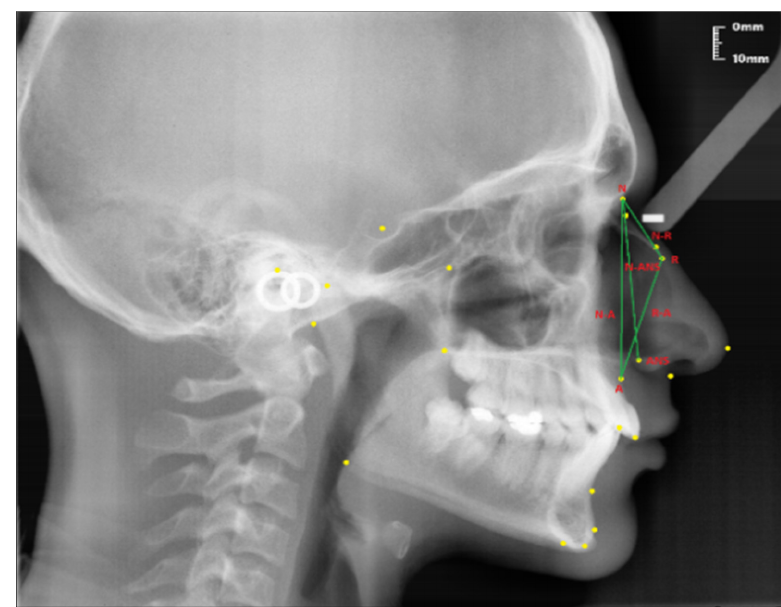
Figure 2. Linear measurements of the nasal profile used in the study.